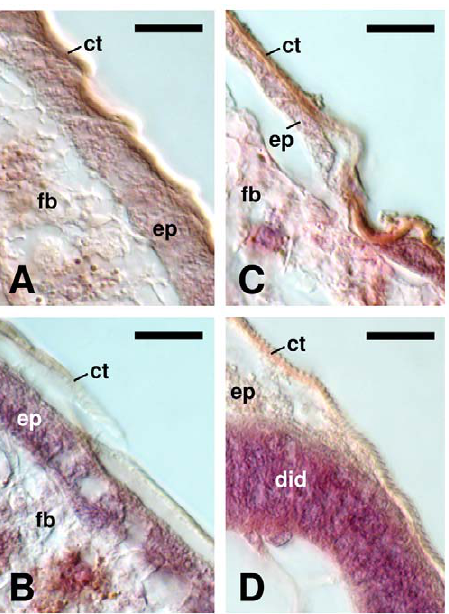
Figure 6. Novaluron modifies cuticle and epidermis aspect of Ae.aegypti larvae. DIC microscopy was performed on histological sections of late L4 larvae stained with HE. ( A ) Control. Note the close association among cuticle, epidermis and the subjacent fat body layer. ( B–D ) Novaluron EI 99 . Cuticle presents a semitransparent and discon- tinuous aspect being detached from the epidermis ( B ); epidermis is thinner ( C ) or degenerated, with a rope-like cuticle ( D ). ct: cuticle, did: disorganized imaginal disc, ep: epidermis, fb: fat body.